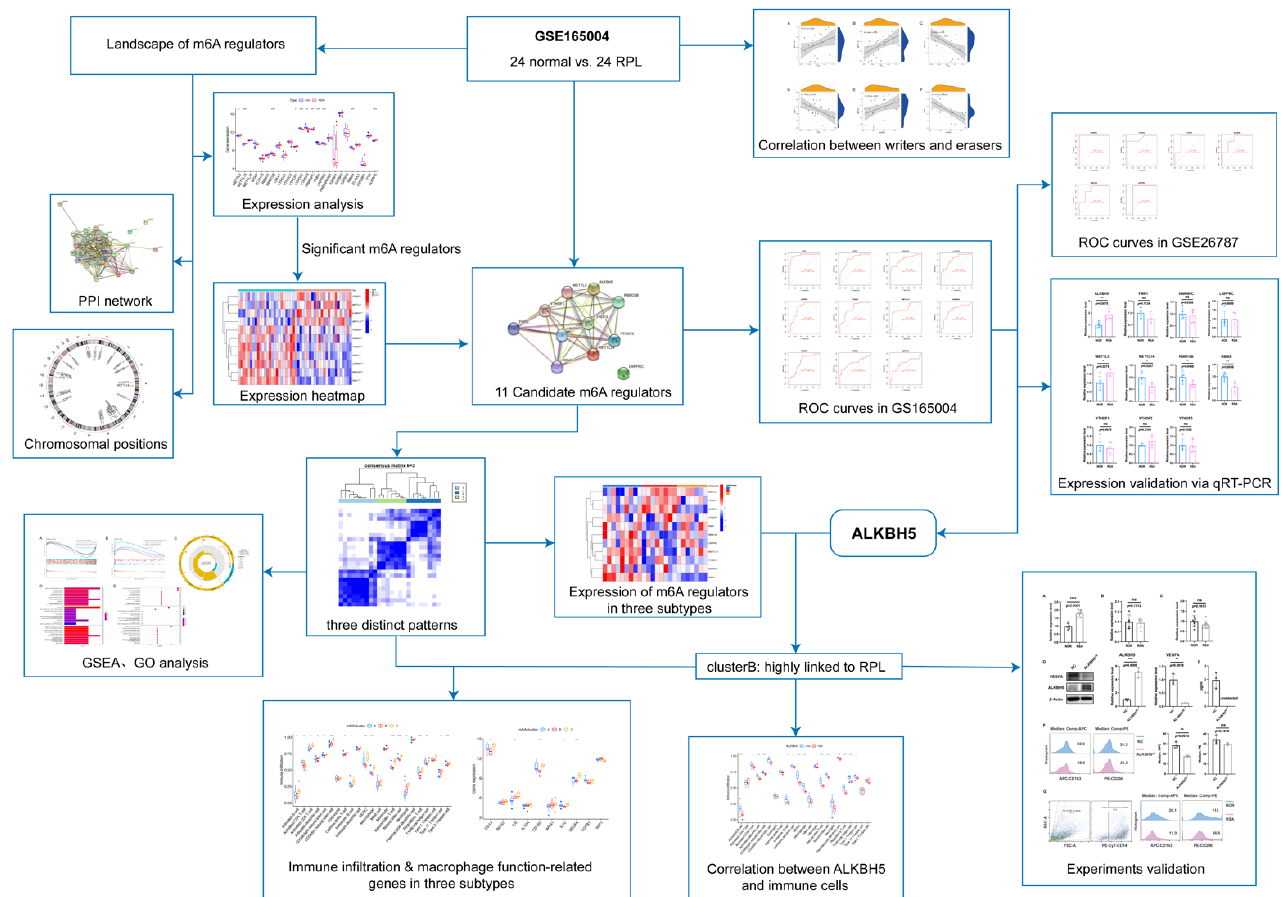
Figure 1. Workflow diagram illustrating the design and processes of our study.